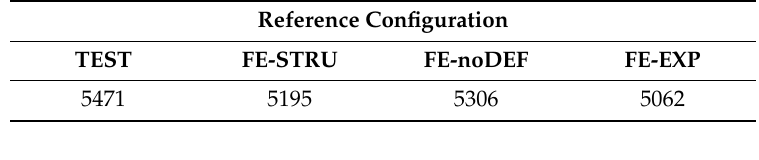
Figure 8. Estimation of the K el stiffness for Standard joints under in-plane lateral loads, based on numerical (ABAQUS) load-displacement curves. Example for the FE-STRU push-out specimen. Table 2. Derivation of the K el [kN/m] for standard joints, according to Figure 8 ( P = 10 kN), for different material properties.